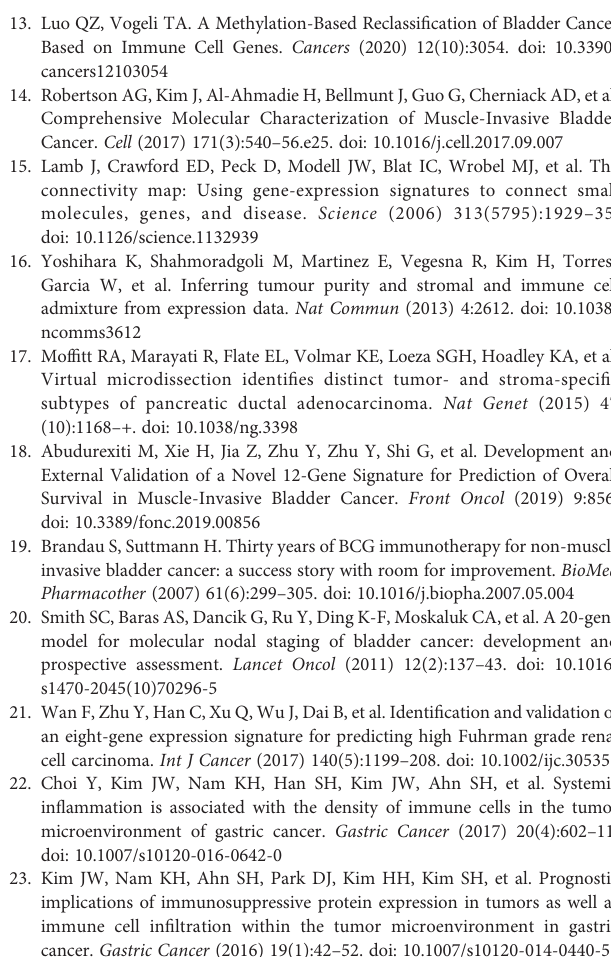
Supplementary Figure 1 | Consensus clustering for BC samples based on TME- related genes. (A) Consensus cumulative distribution function plot. (B) Consensus matrix for k=3. (C) Boxplot of enrichment scores of hallmark features among three subclasses. (D) Boxplot of immune suppressive and immune active genes among three subclasses. (E) Boxplot of immune checkpoint genes expression among three subclasses. (F) Bar plot of the ICB response predictions among three subclasses. (G) Forest plot of the log odds ratio for signi fi cantly different gene mutations. Supplementary Figure 2 | Risk score analysis, time-dependent ROC analysis and Kaplan – Meier analysis for the validation of prognostic model in (A) internal train set and (B) internal validation set. Supplementary Figure 3 | Forest plots for clinical factors and risk score. (A) Univariate cox forest plot for age, sex, stage and risk score. Age, stage and risk score were statistically signi fi cant. (B) Multivariate cox forest plot for age, sex, stage and risk score. The risk score calculated by fi ve-gene signature was still an independent predictor. (C) The c-index scores for age, stage and riskscore. Time-dependent ROC analysis of age, stage and riskscore for (D) one-year survival (E) three-year survival (F) fi ve-year survival. Supplementary Figure 4 | Mutation and CNV differences of high- and low-risk groups. (A) Oncoplot for the top mutation genes. (B) Forest plot of the log odds ratio for signi fi cantly different gene mutations. (C) Numbers of ampli fi cation and depletion differences of high- and low-risk